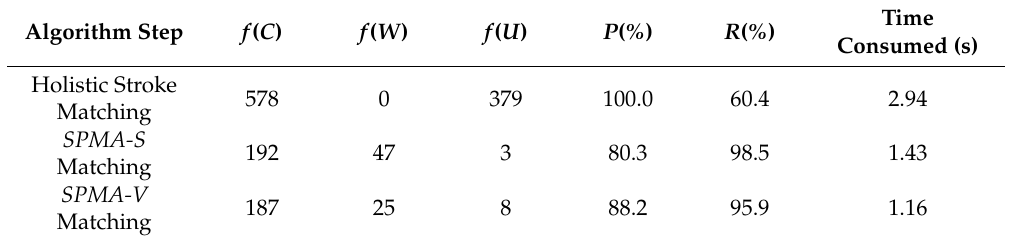
Table 3. Statistics of the matching performance at each step of the “stroke algorithm”.